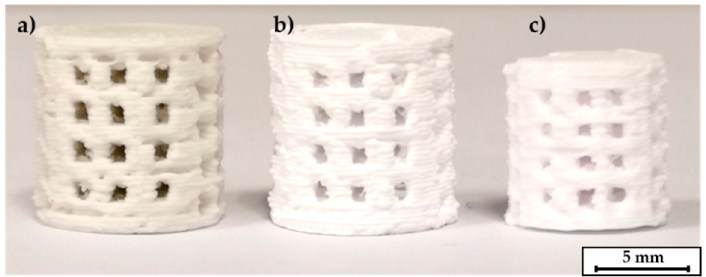
Figure 6. C2 based printed scaffolds: ( a ) green body, ( b ) after debinding, ( c ) as fired.